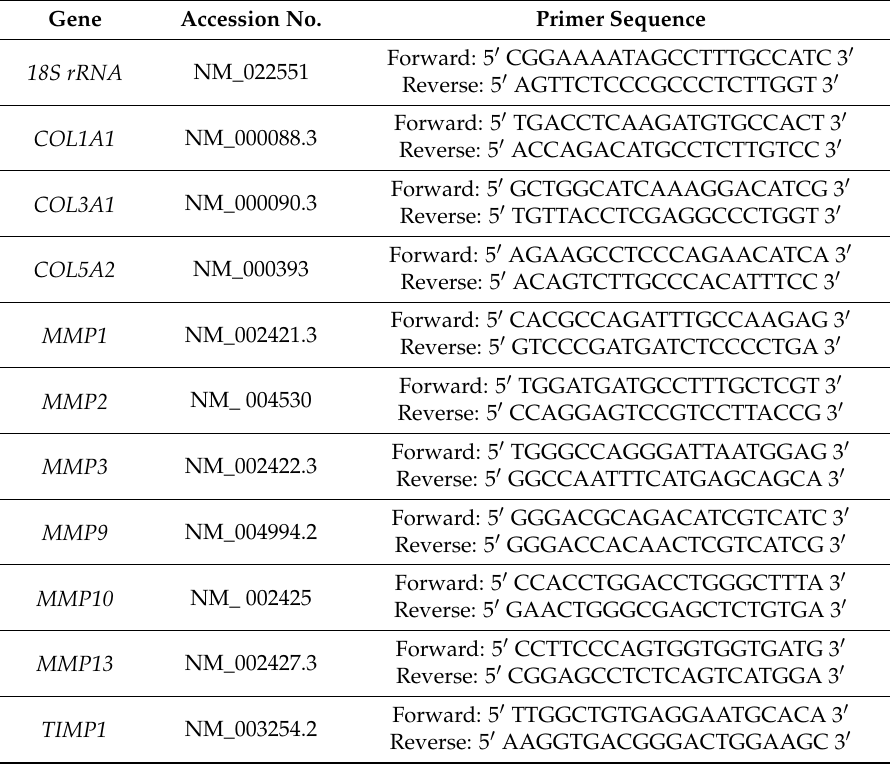
Table 2. qRT-PCR